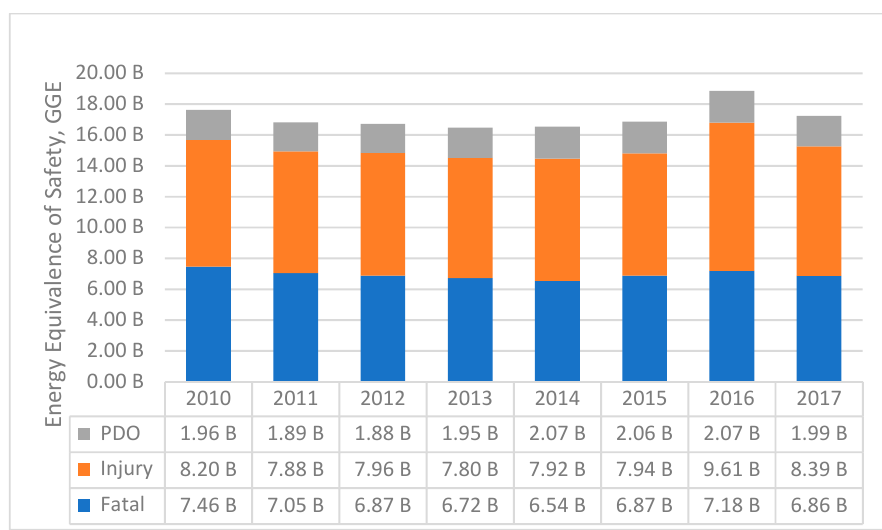
Figure 7. Total gasoline gallon equivalent (GGE) cost from 2010 to 2017.